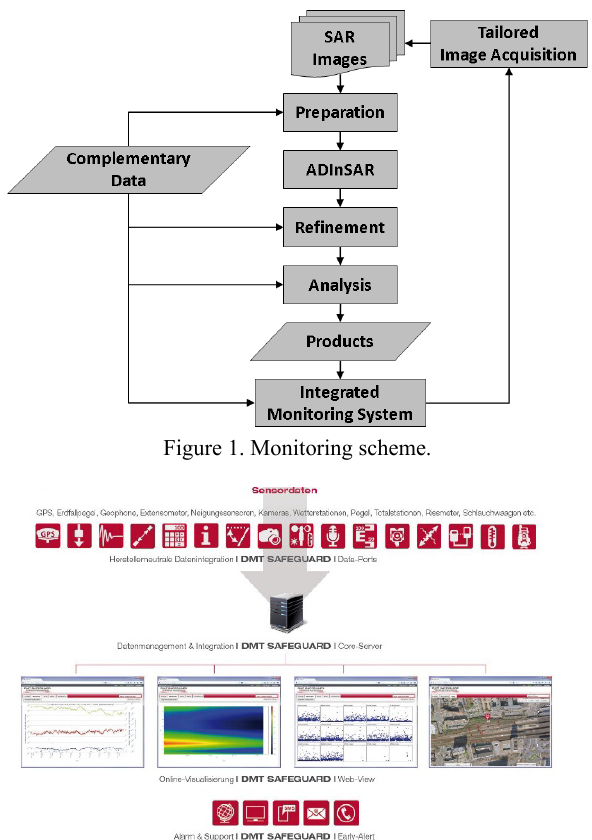
Figure 2. DMT SAFEGUARD – intergrated monitoring platform.